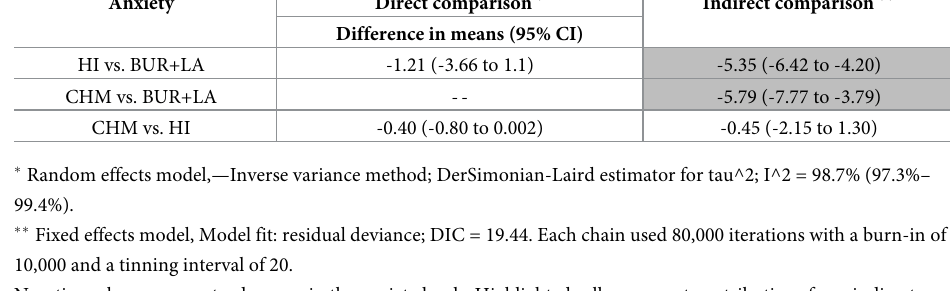
Table 3. Mixed treatment comparison (MTC) model comparing anxiety among treatments. Anxiety Direct comparison � Indirect comparison �� Difference in means (95% CI)